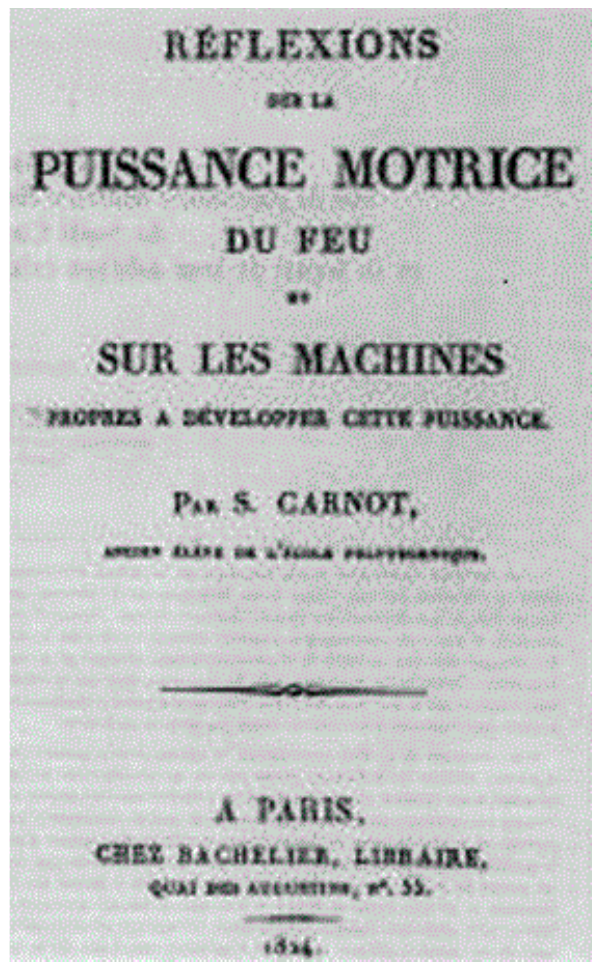
Figure 1. Front page of the original work of